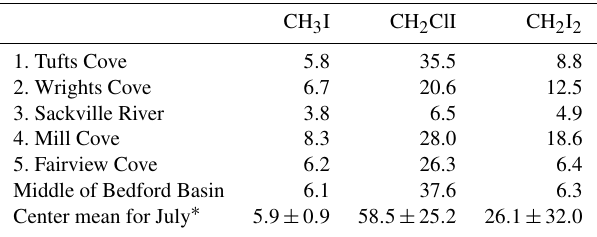
Figure 6. Variation of the net production rate of CH 3 I in the up- per 10m from 2015 to 2017. No data are plotted when the layer of uniform density extended below 10m.